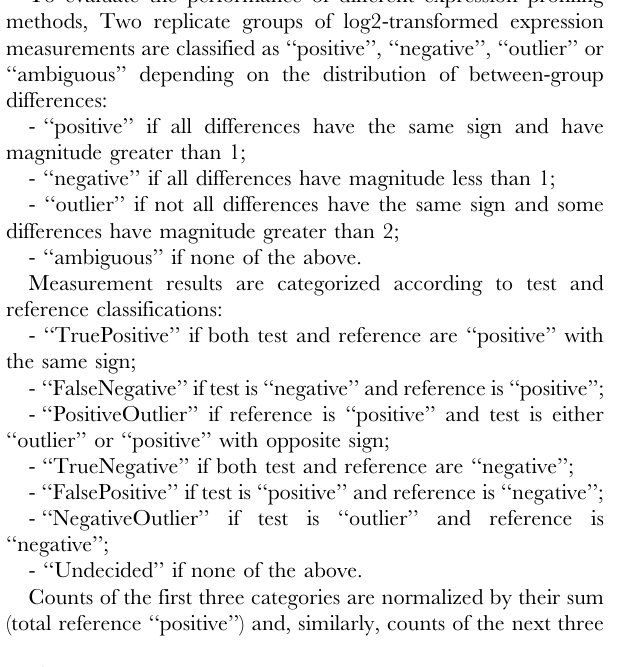
Figure S1 Size distribution of amplified cDNAs from different amounts of starting material. Typical electropherograms of WTA amplified cDNAs from 0 pg RNA (A), 10 pg (B), 100 pg (C) and 1000 pg RNA (D). TIF) Figure S2 Probe signal intensities of microarrays hybridized with cDNA generated from different amounts of RNA. 10 m g cDNA was generated by WTA amplification from the indicated amounts of RNA and hybridized to Gene ST arrays. Whiskers indicate range, boxes the 25th and 75th percentile, and horizontal lines within boxes indicate the median. Figure S3 Influence of expression levels on the correlation of microarray versus qPCR measurements of differential expression. Transcripts were divided into high-copy-number and low-copy numbers according to the Ct values from qPCR measurements. Correlation of qPCR measurements versus microarray measure- ments for high abundance transcripts (A and C) and low abundance transcripts (B and D) measured from 25 ng RNA (A and B) and 100 pg respectively (C and D). Figure S4 Integrity of RNA after magnetic bead purification. Typical electropherograms of RNA isolated from (A) SW480 and (B) SW620